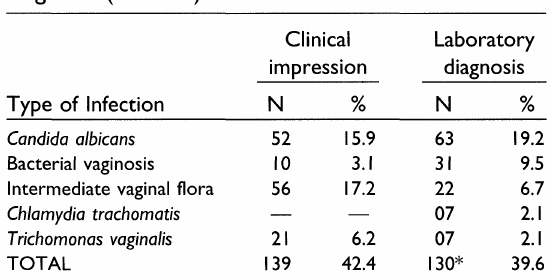
TABLE I. Prevalence of the different types of genital infection according to clinical and laboratory diagnosis